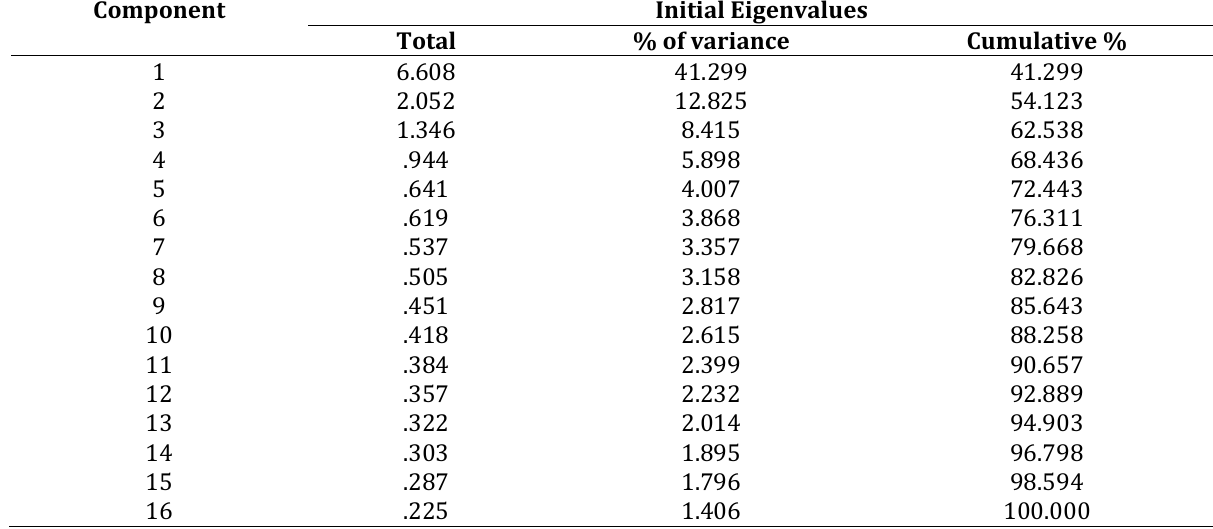
Table 16: Results of Eigen analysis of covariance matrix of the warehouse performance